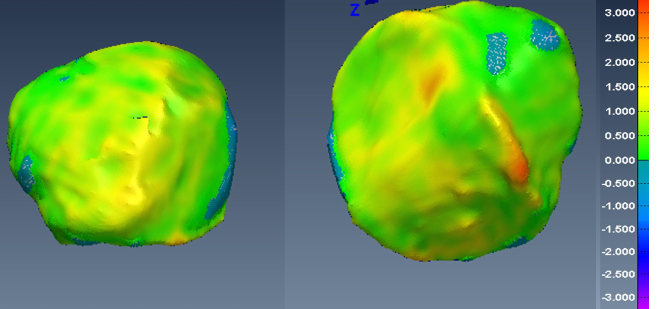
Figure 16. Two views of the colour-coded signed distance in mm between the U-Net 3D mesh and the UofA 3D mesh for the